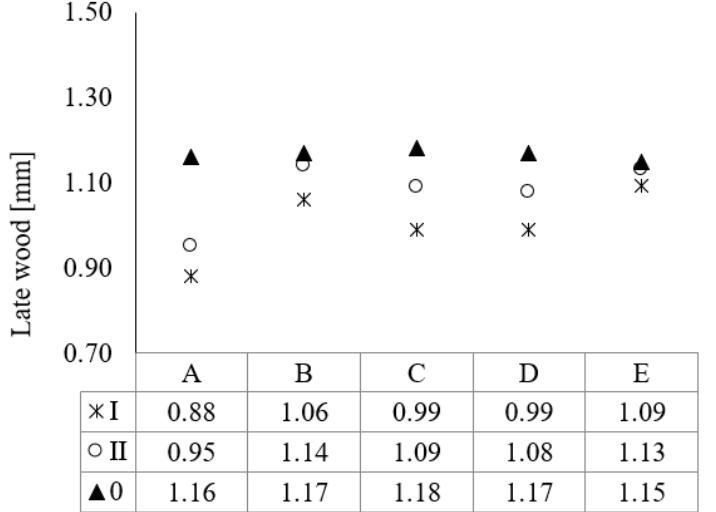
Figure 4. Increment variability on the thickness of latewood depending on the pruning variant and the amount of time since the procedure (0 = up to 15 years, I = 16–25 years, II = 26–35 years). It was assumed that there would be a relationship between pruning, the increment